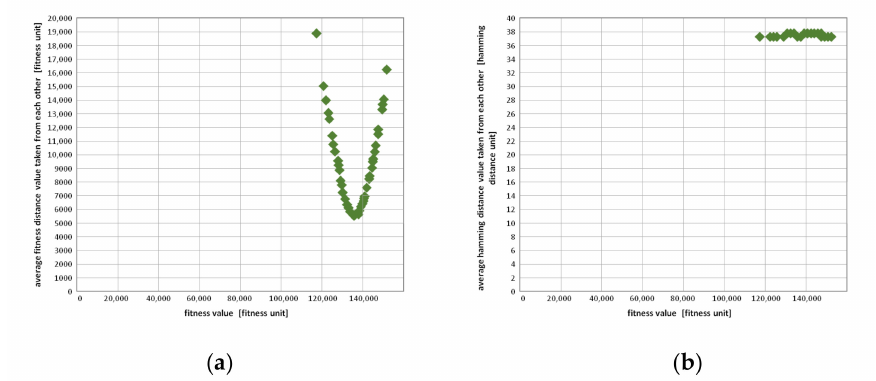
Figure 6. The fitness distance ( a ) and the hamming distance ( b ) of